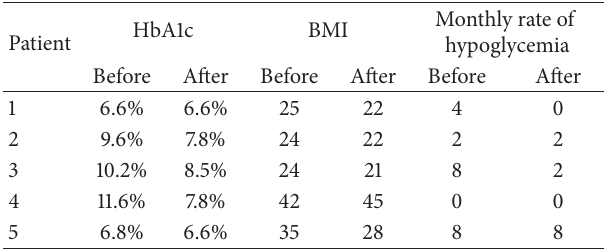
Table 2: Outcomes of SGLT2 therapy in type 1 diabetic